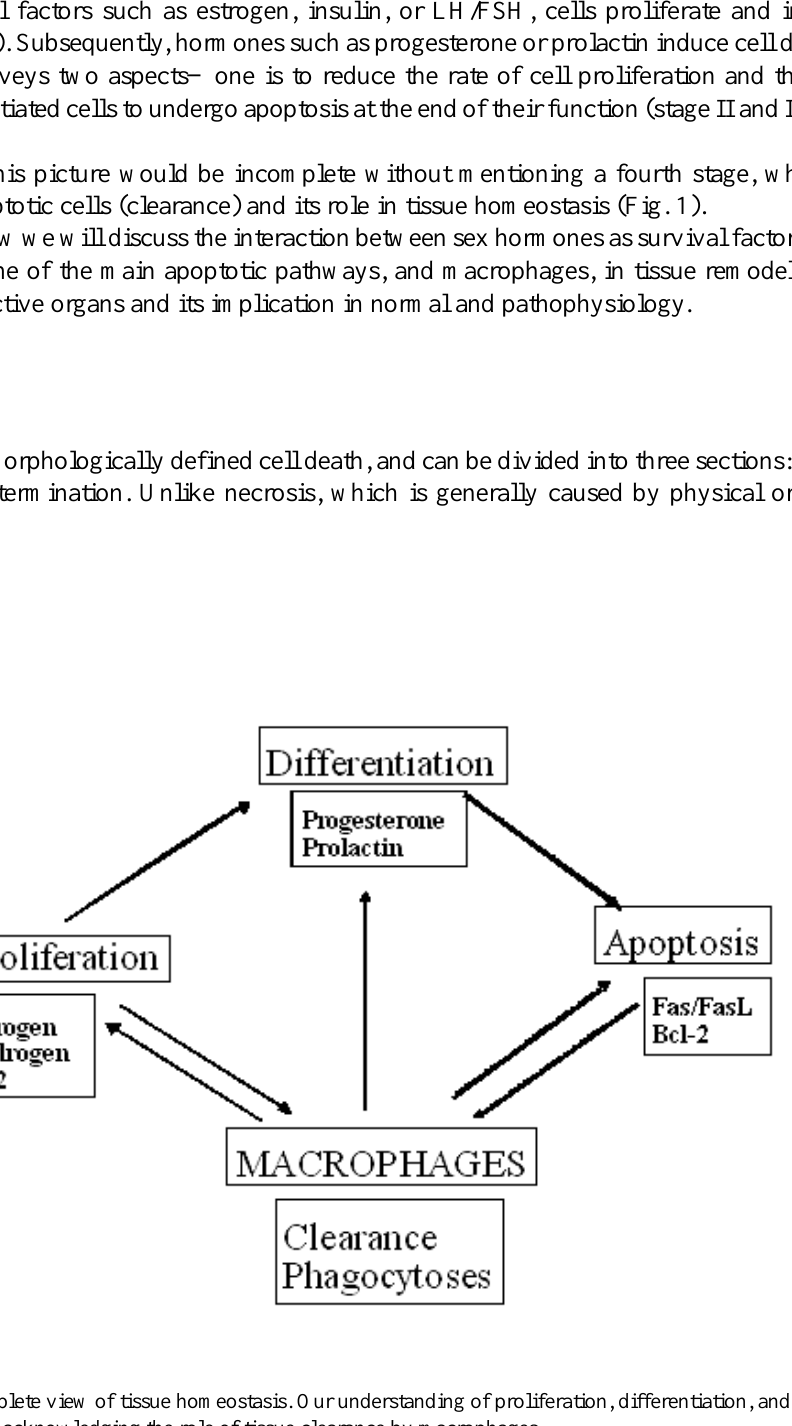
FIGURE 1 . A complete view of tissue homeostasis. Our understanding of proliferation, differentiation, and cell death is incomplete without acknowledging the role of tissue clearance by